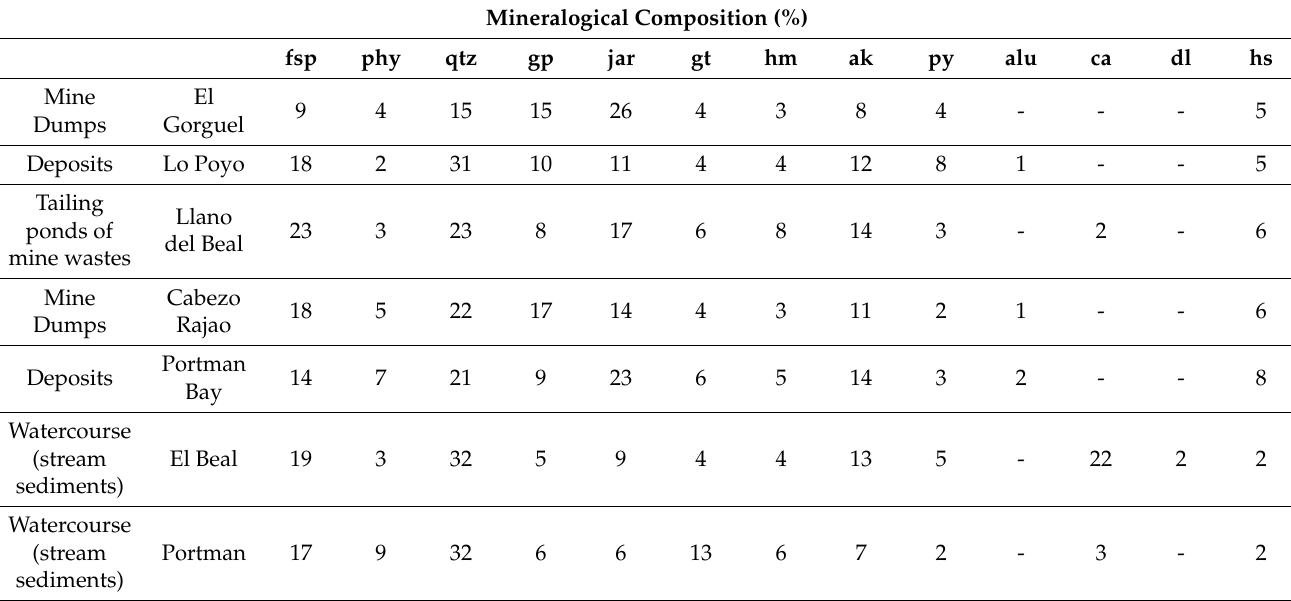
Table 3. Mineralogical characteristics of the abandoned residues of the study area [38].